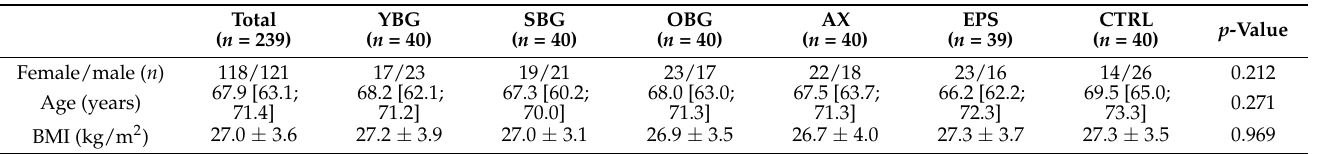
Figure 2. CONSORT flow diagram of the pilot study. YBG: yeast β -glucan, SBG: shiitake β -glucan, OBG: oat β -glucan, AX: arabinoxylan, EPS: exopolysaccharide, CTRL: control. Table 1. Baseline characteristics of the study